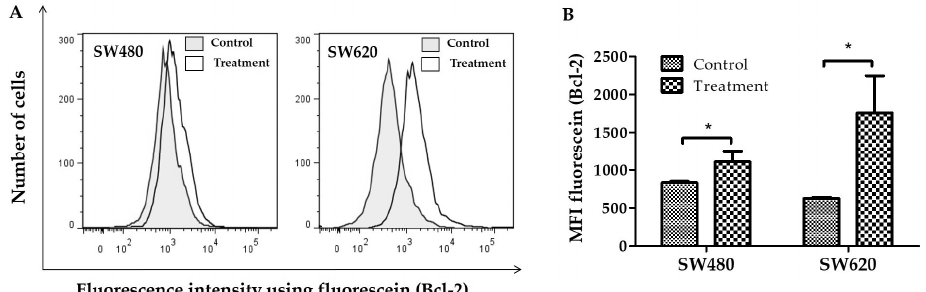
Figure 2. Effect of LMPE on mitochondrial membrane potential change ( ∆Ψ m ) in SW480 and SW620 cell lines. Histograms represent fluorescence intensity using DiOC 6 (detected by flow cytometry) in SW480 and SW620 ( A ) cells. The cells with the permeability of the mitochondrial membrane are located at L1 and the cells with polarized mitochondria are at L2. Percentage of SW480 and SW620 cells with the polarized mitochondrial membrane ( B ). Cells were exposed to 30 mg LMPE/mL for 48 h. Untreated cells (0 mg LMPE/mL) were used as a control. Data were expressed as mean ± SEM ( n = 3). The differences between the control and treated cells were analyzed with Student’s t test, ns = non-significant difference, p = 0.2368 (SW480), and p = 0.8514 (SW620).